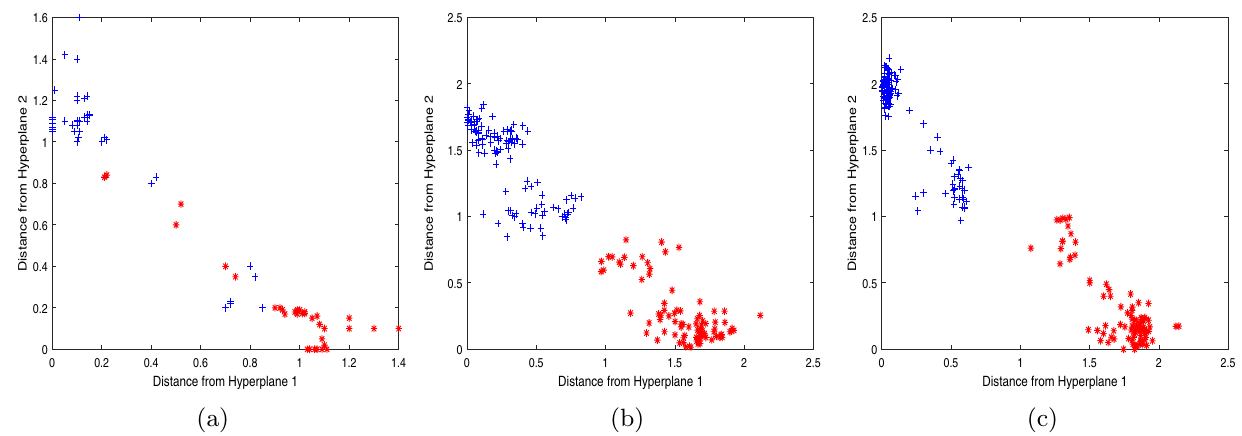
Figure 4. Two-dimensional projections NPSVM, ν -NPSVM and ν -IMNPSVM for 200 test points from the Australian data set. +: scatter plot of the positive point; ∗ : scatter plot of the negative point. ( a ) NPSVM, ( b ) ν -NPSVM, ( c ) ν